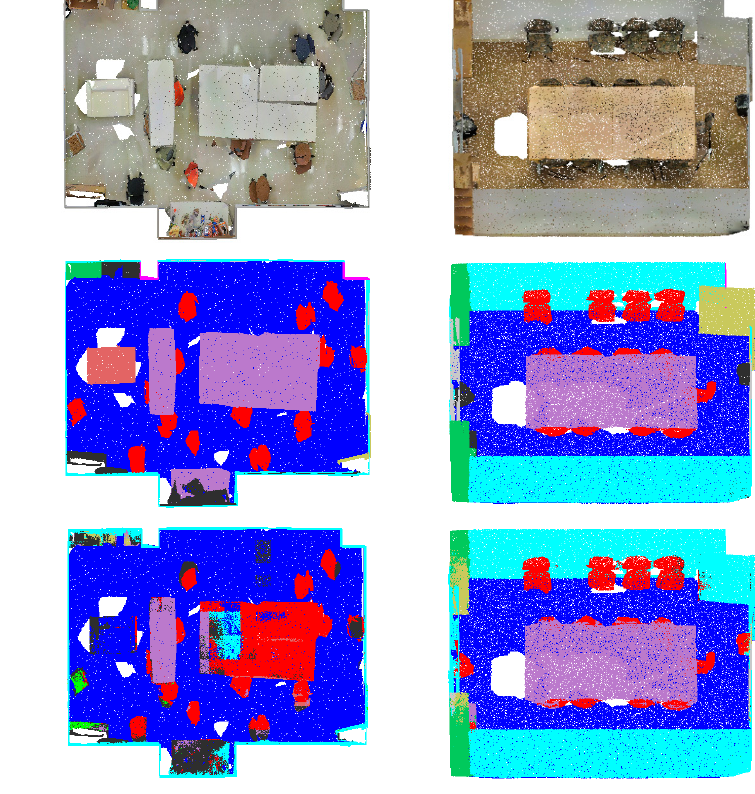
Figure 6. Segmentation results of the Area 5: ( a ) the original point cloud data; ( b ) ground truth; ( c ) the segmentation results using the HPRS network. Table 5. Quantitative results of different approaches for the Area 5 (%).